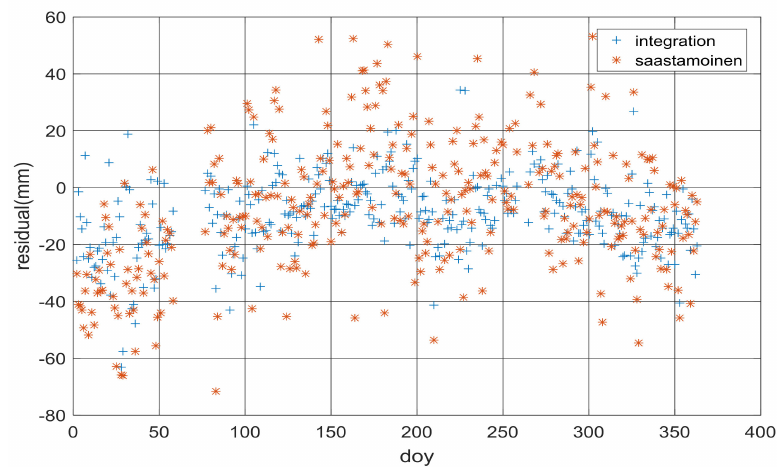
Figure 2. Tropospheric delay residual of the integral method and model estimation